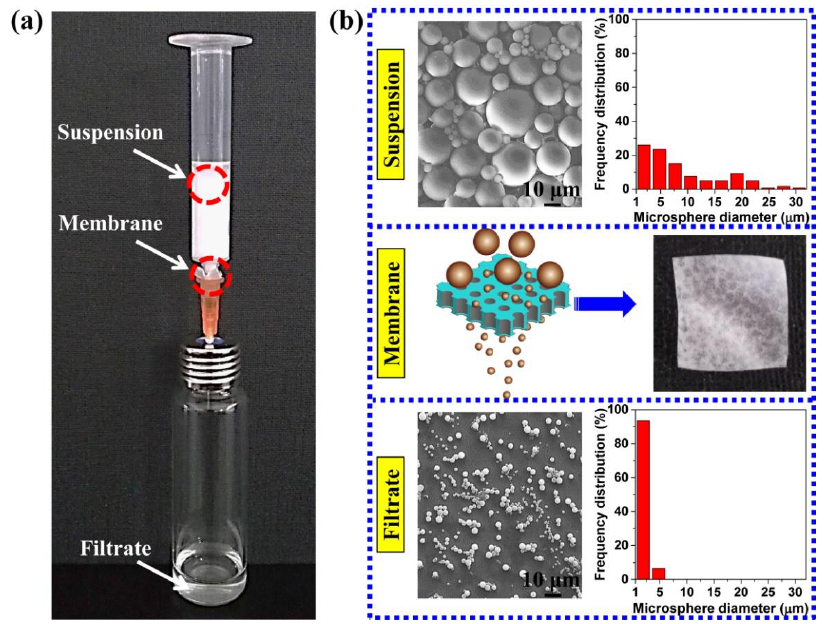
Figure 10. ( a ) the optical photograph of filtration process. ( b ) SEM images and optical photograph of suspension, filtrate and membrane.